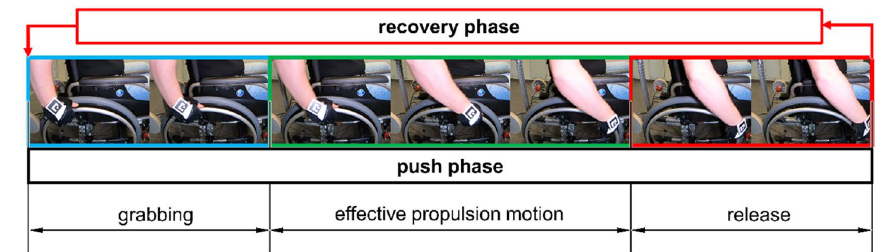
Figure 1. Schematic illustration showing the push phase broken down into individual